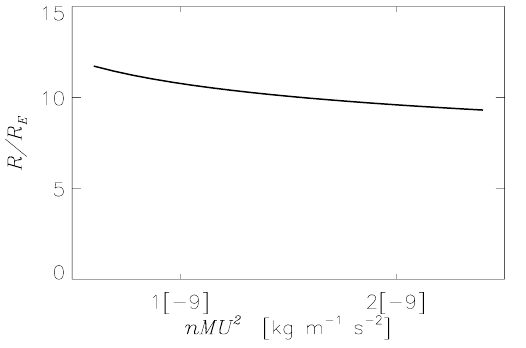
Fig. 2. Normalized Earth-magnetopause distance R/R E for varying dynamic solar wind pressure nMU 2 .